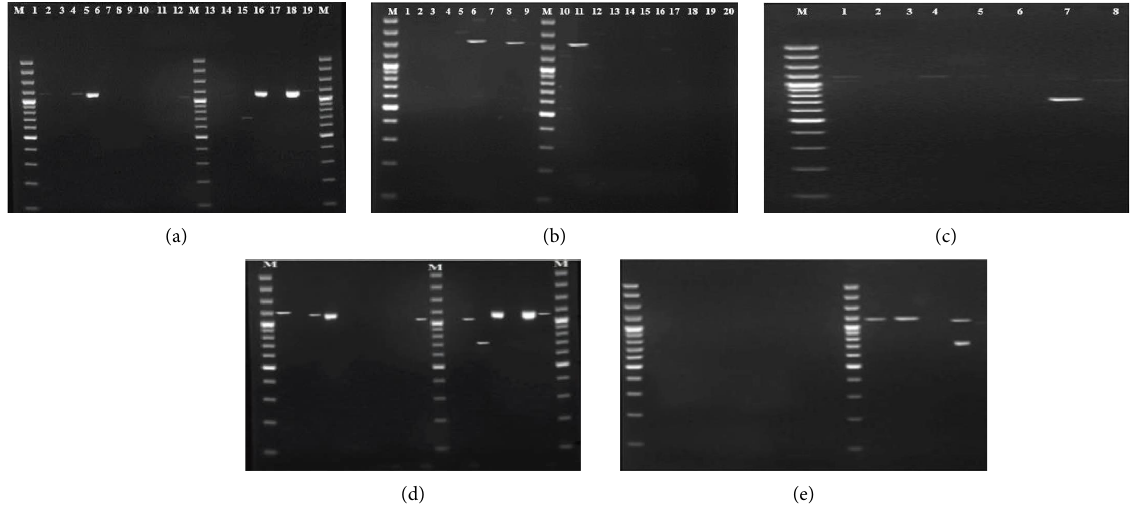
Figure 3: (a) Ladder size: 3000bp, lines 1–3–4–5–12–14–16–18–19: cnf1 positive (1111bp); line 15: cnf3 positive (757 bp). (b) Ladder size: 3000bp, lines 6–8–11 cnf2 positive (1240bp). (c) Ladder size: 3000bp, line 4, 5, 6, and 8 cnf1 positive (1111bp), line 1; both cnf1 positive